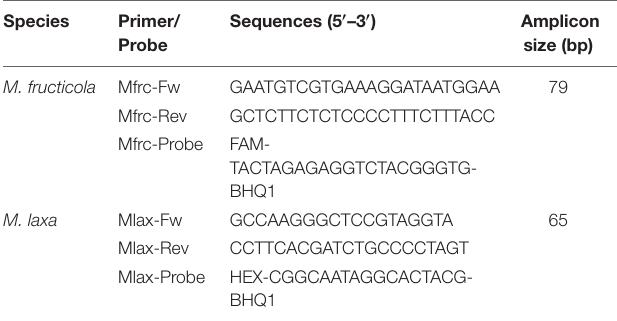
TABLE 1 | Primers/TaqMan probe sets (Abate et al., 2018). Species Primer/ Sequences (5 (cid:48) –3 (cid:48) Probe